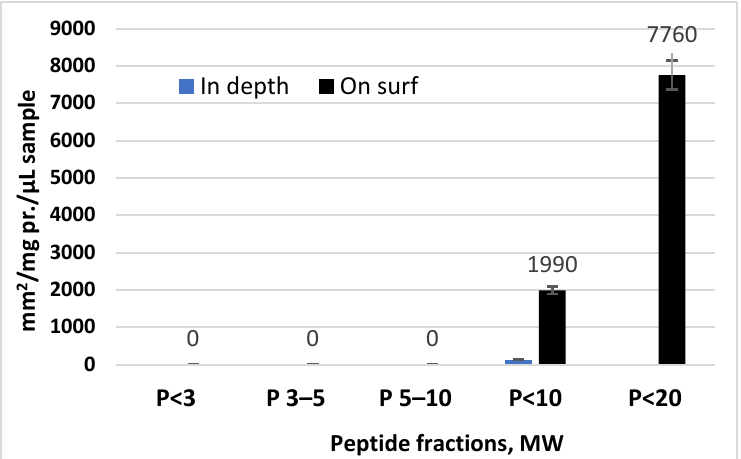
Figure 5. Antibacterial effect of the peptide and protein fractions regarding E. coli NBIMCC 8785 in surface and deep inoculations.